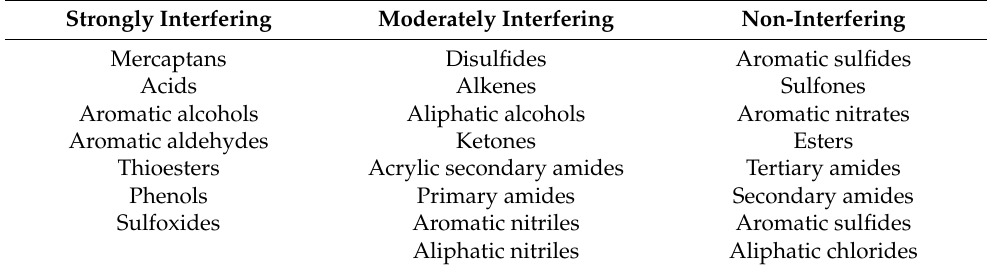
Table 1. The chain transfer behavior of some of the functional groups of the CROP of 2-oxazoline monomers